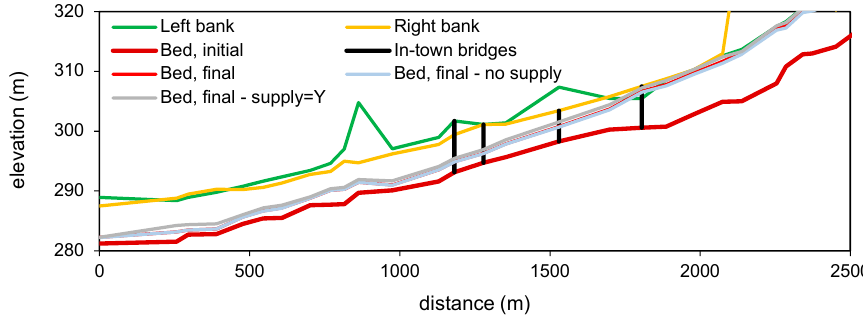
Figure 16. Model of the design flood scenario: sensitivity to the sediment supply at the upstream boundary (equilibrium conditions for the benchmark model, no supply, Y = 2 × 10 5 m 3 ).